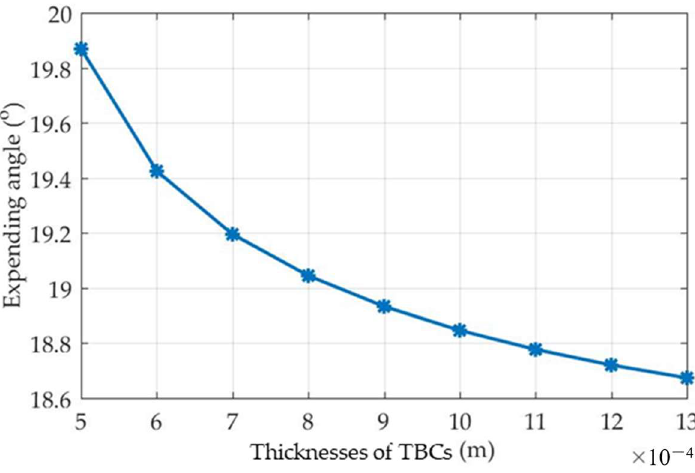
Figure 11. The relationship between the cooling air ratio and TBC thickness.